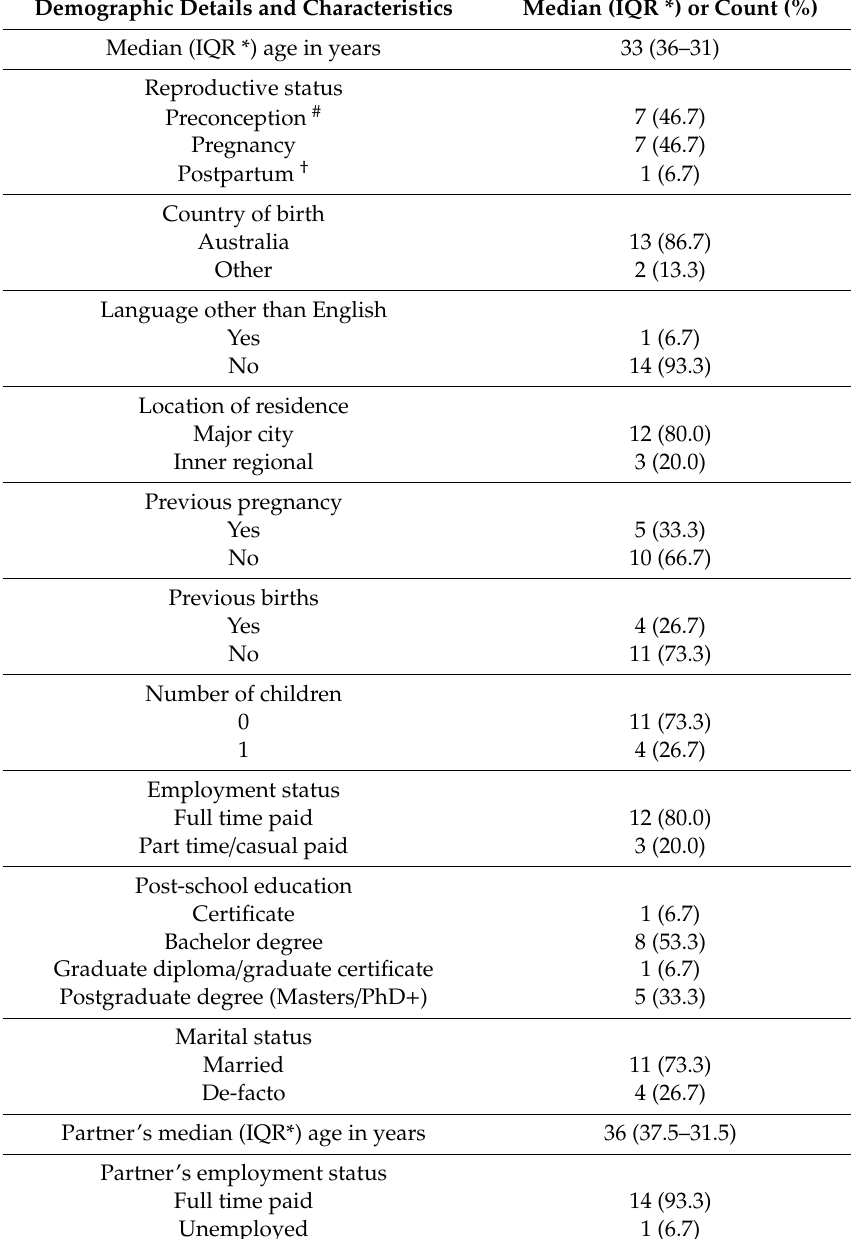
Table 1. Demographic details and characteristics of n = 15 participating women. Demographic Details and